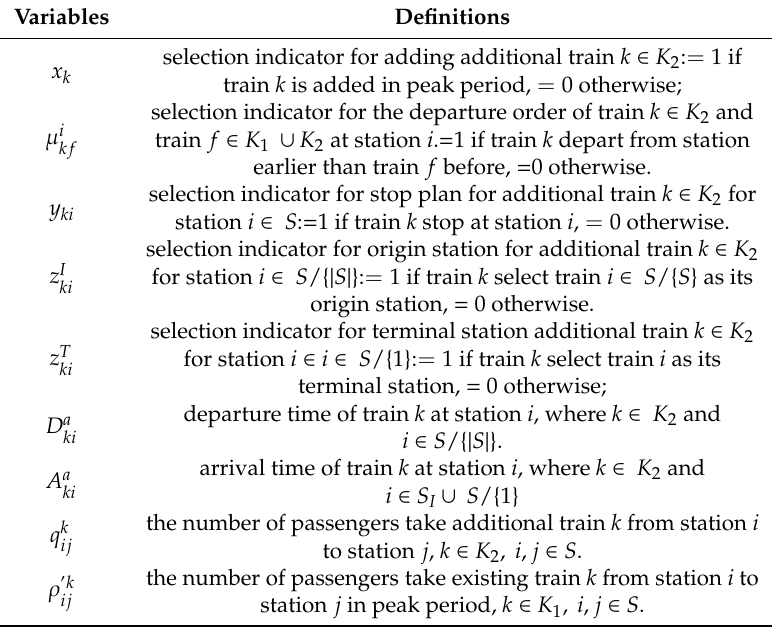
Table 4. Decision